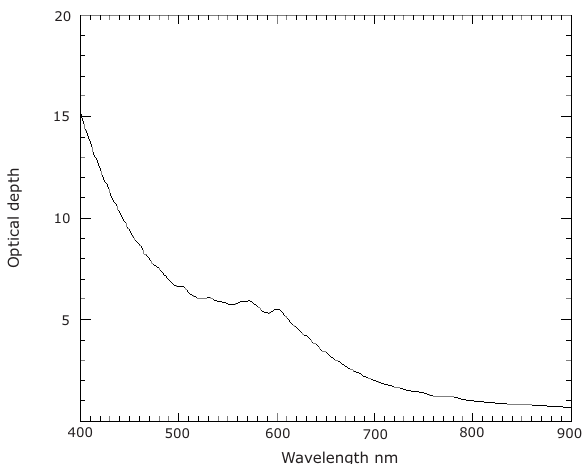
Fig. 8. Typical wavelength dependence of the optical depth to Longyearbyen from the sun. Only wavelengths longer than 690nm have an optical depth less than 2 explaining the deep red colour of the phenomenon.